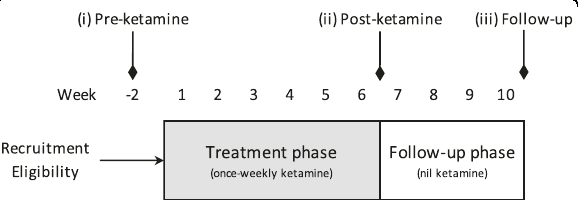
(MRI) and electroencephalogram (EEG) assessments (data not reported here).